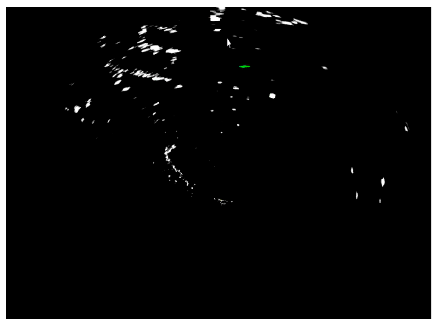
Figure 2. PPI information of vessel navigation (single targets).